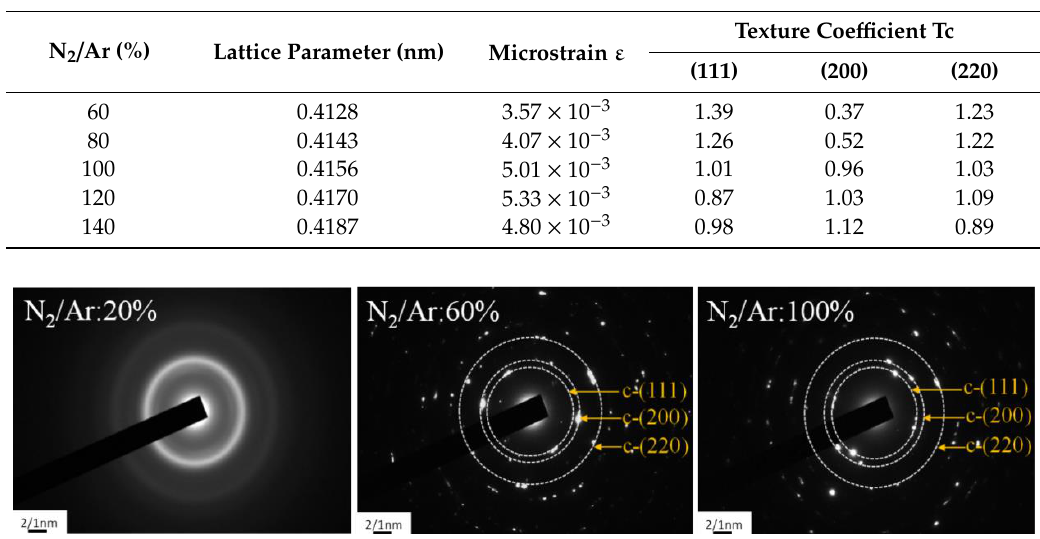
Figure 1. Grazing incidence X-ray di ff ractometer (GIXRD) profiles of CrAlN layers as a function of N 2 / Ar flow ratio. Table 2. Lattice parameters and texture coe ffi cient of CrAlN layer under various N 2 / Ar flow ratios.